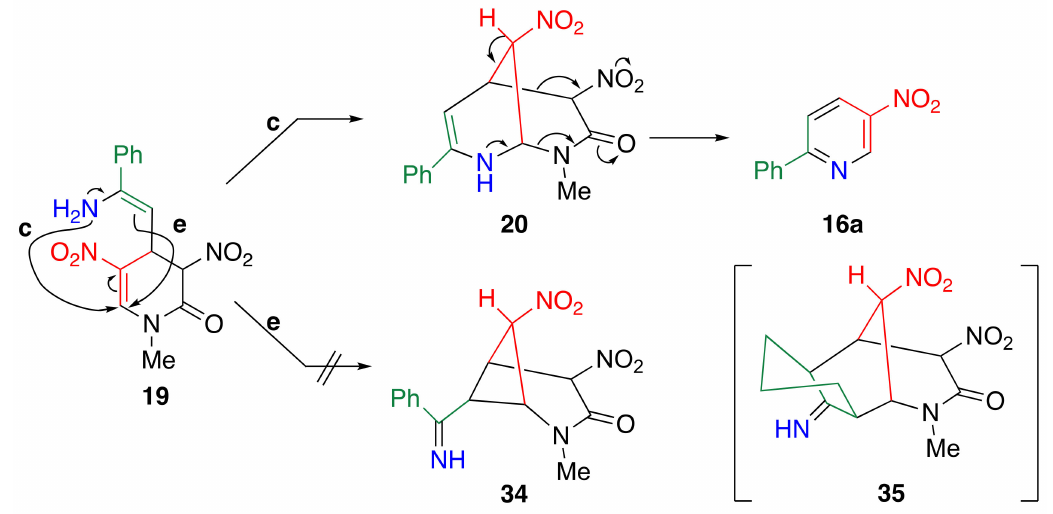
Scheme 12. Plausible mechanism using aromatic ketone 15 and cycloalkanone 13